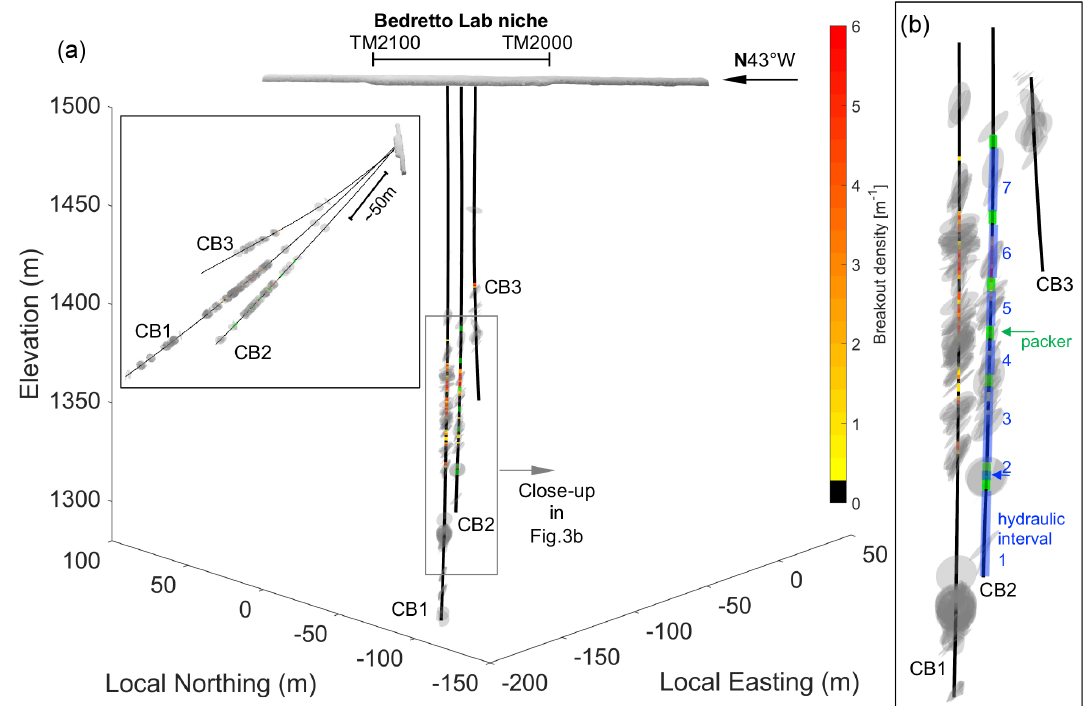
Figure 3. Configuration of boreholes CB1, 2 and 3 and the mapped major fractures and fault zones therein. (a) Looking down approximately normal to the three boreholes. Inset shows the side view of the boreholes. (b) Close-up of the major fault zone interval. Note the breakout density along the CB borehole major fault zone and the multi-packer system (and the divided hydraulic intervals) installed in CB2 (see Table 2 for